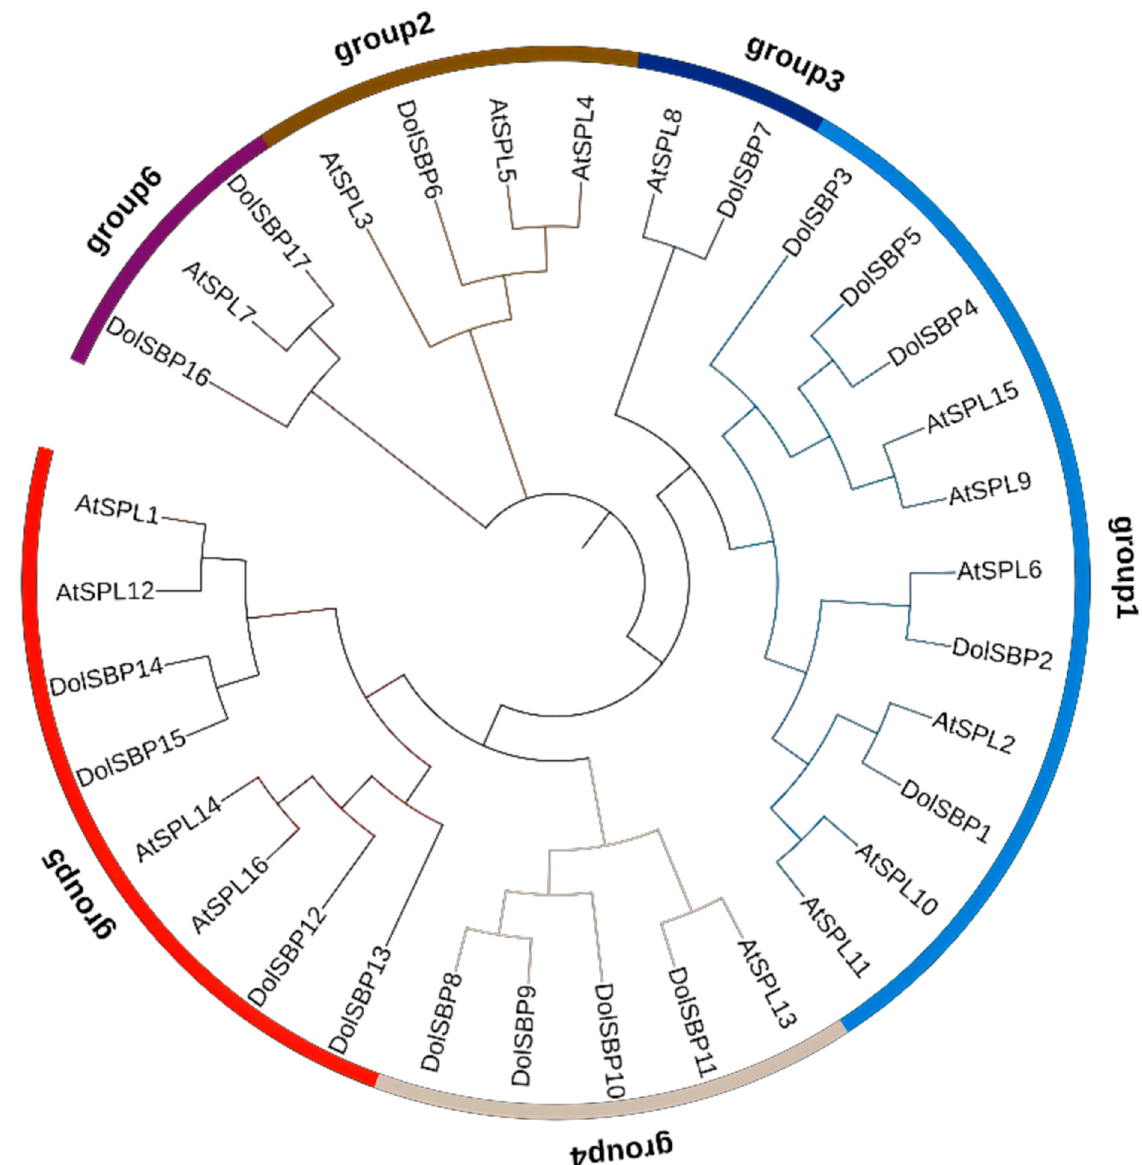
Figure 9. The phylogenetic tree of SBP-box genes in D. oleifera . The tree was visualized with the iTOL program. Different colours represent different groups.